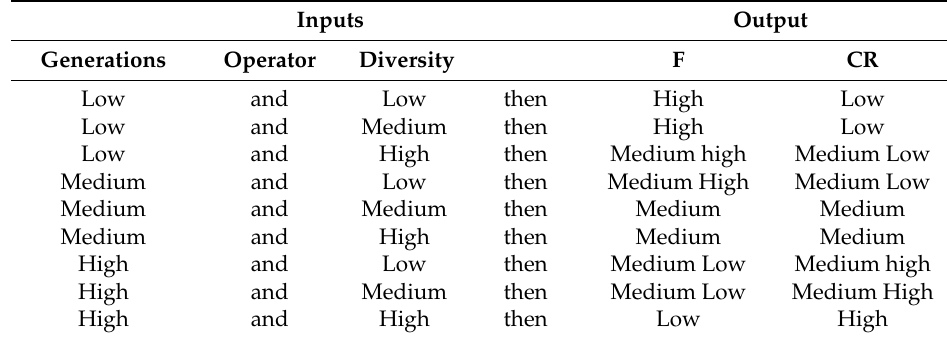
Figure 11. Fuzzy differential evolution algorithm. Table 2. Fuzzy rules for the FDE.